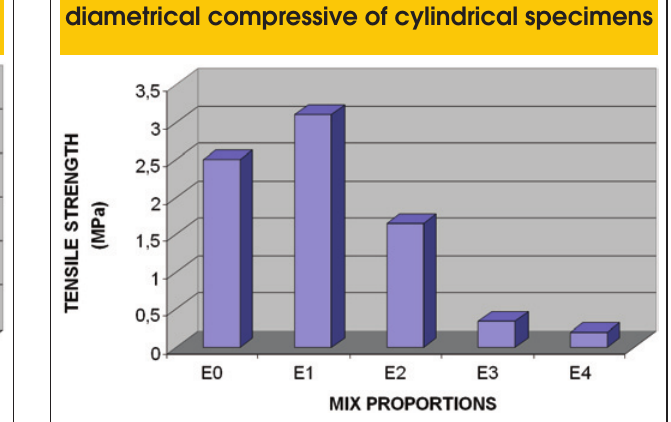
Figure 6 – Results of tensile strength by average diametrical compressive of cylindrical